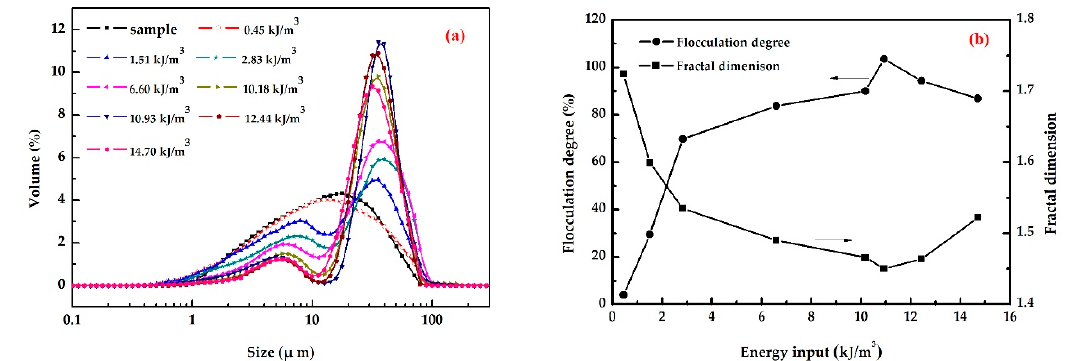
Figure 6. Effect of energy input on the ( a ) flocs size distribution (FSD) and ( b ) fractal dimension ( D f ) of fine diaspore.